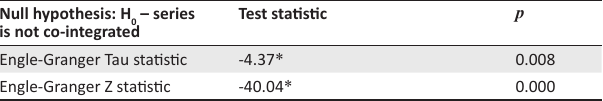
TABLE 7: Engle-Granger co-integration test.